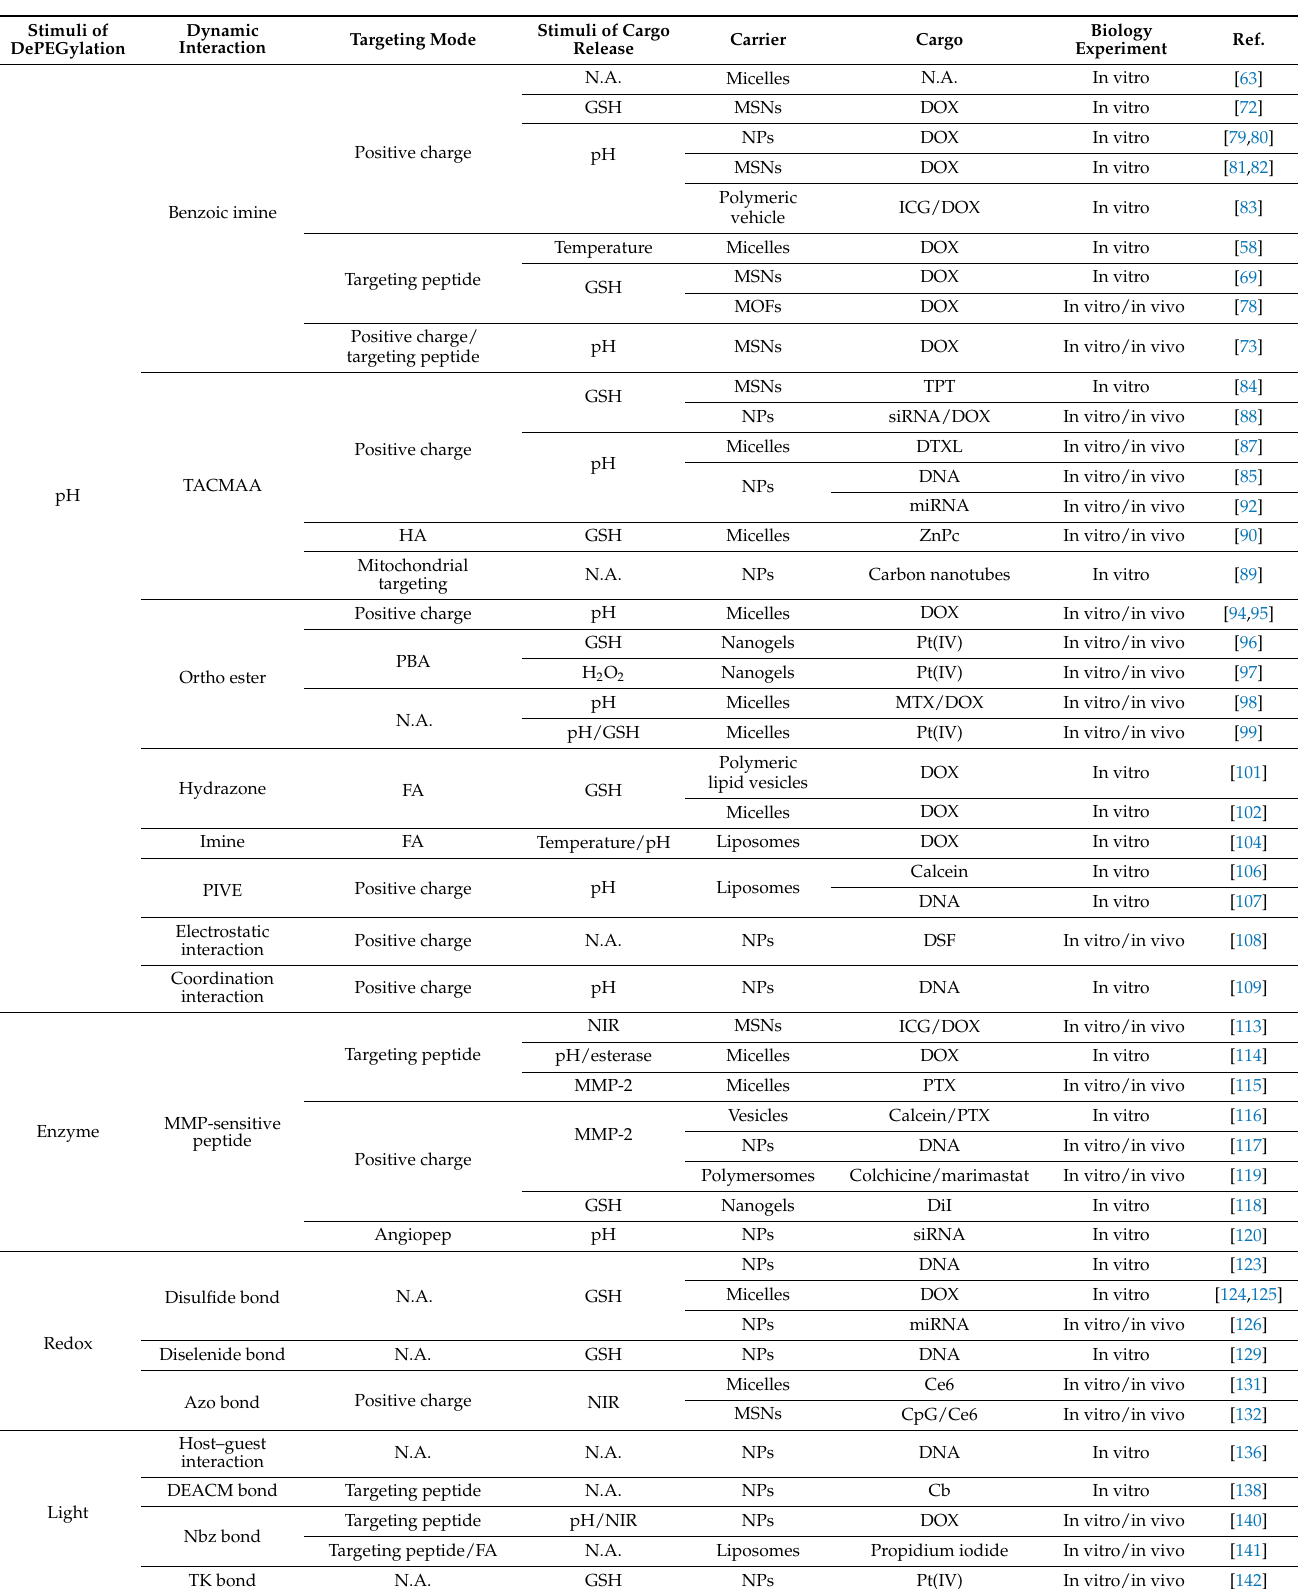
Table 1. Summary of DDSs with DePEGylaiton-based “tumor-triggered” targeting or intracellular drug release